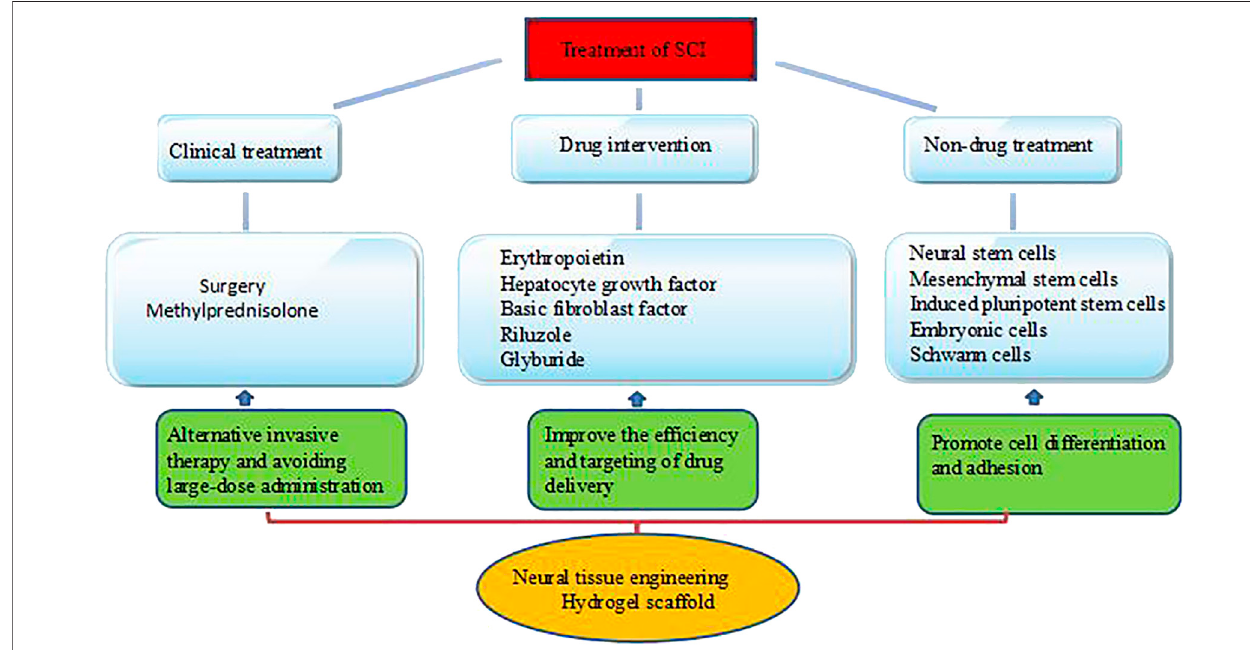
FIGURE 2 | Current treatment and limitations of SCI.